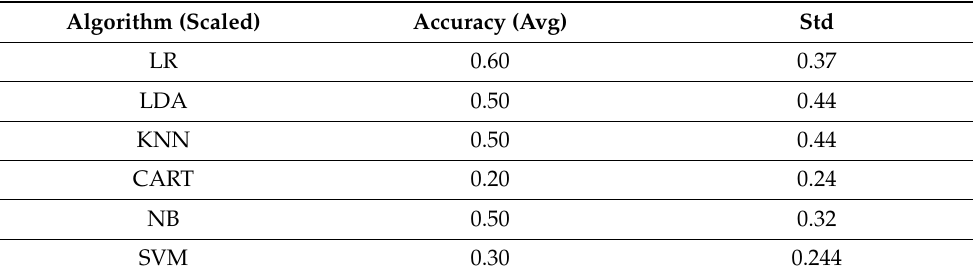
Table 5. Algorithm performance after Scaling the